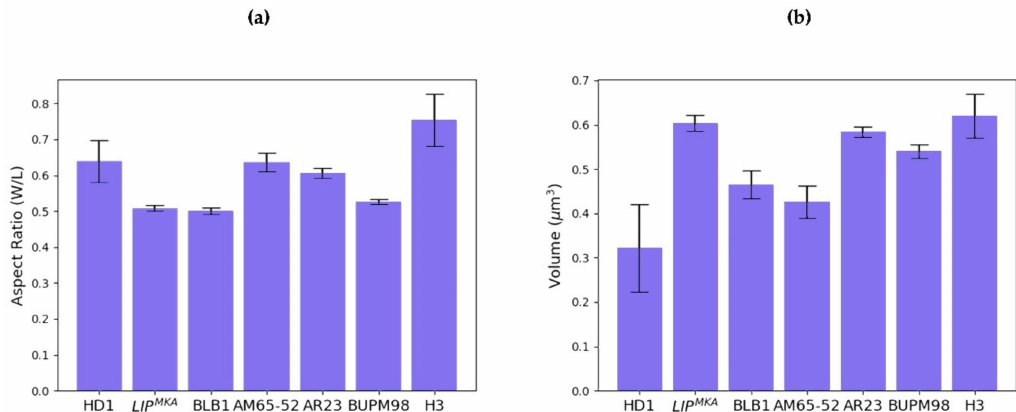
Figure 10. Mean values of ( a ) spores aspect ratio and ( b ) volume of spores for the seven strains of B. thuringiensis. Error bars are uncertainties computed while taking into account the standard deviation for N